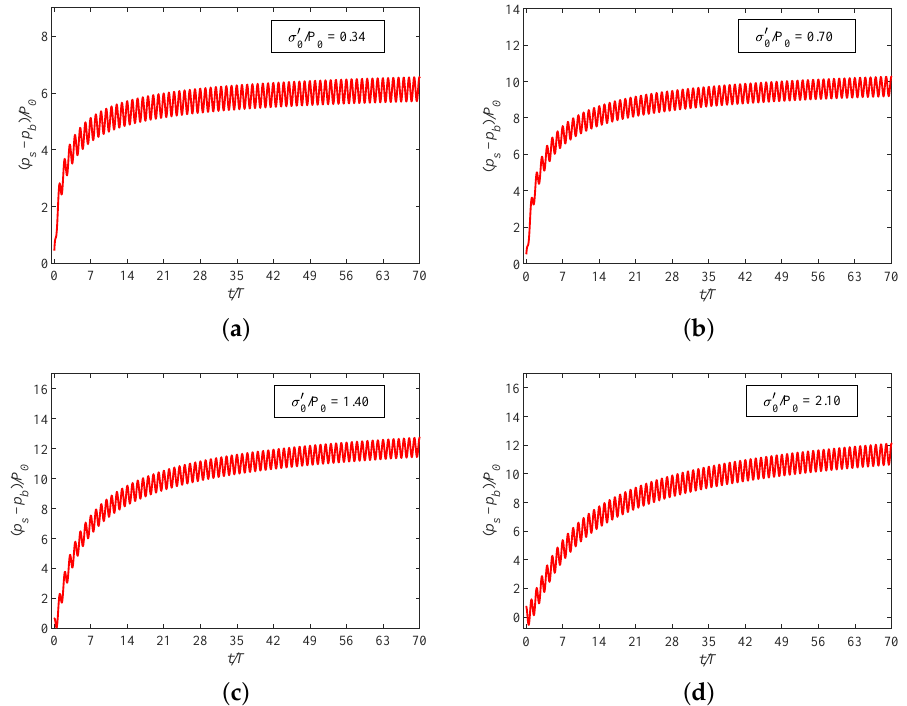
Figure 8. The development of the pore pressure over wave cycle ( t / T ) for Case 2; ( a ) (x,z) = (31.0, − 0.5) m; ( b ) (x,z) = (31.0, − 1.0) m; ( c ) (x,z) = (31.0, − 2.0) m; ( d ) (x,z) = (31.0, − 3.0) m.